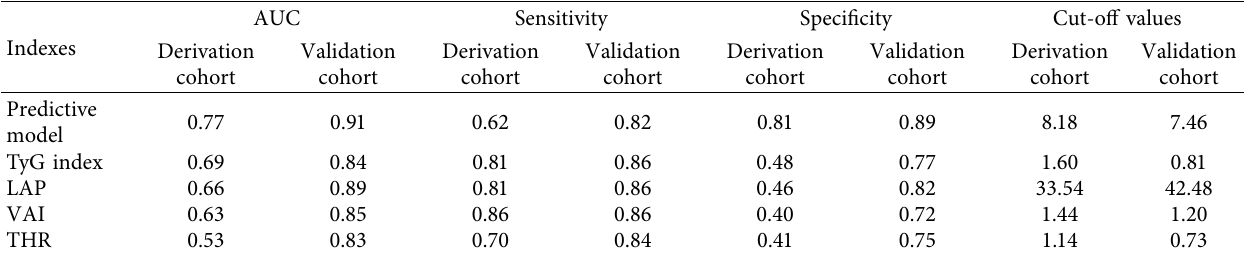
Table 4: The AUC, sensitivity, specificity, and cut-off points for each index for predicting IR.